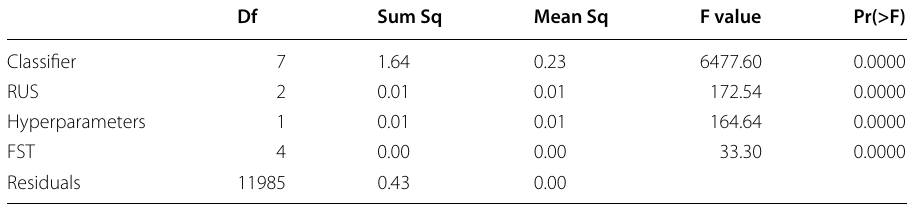
Table 37 ANOVA for classifier, RUS, hyperparameters and FST as factors of performance in terms of AUC Df Sum Sq Mean Sq